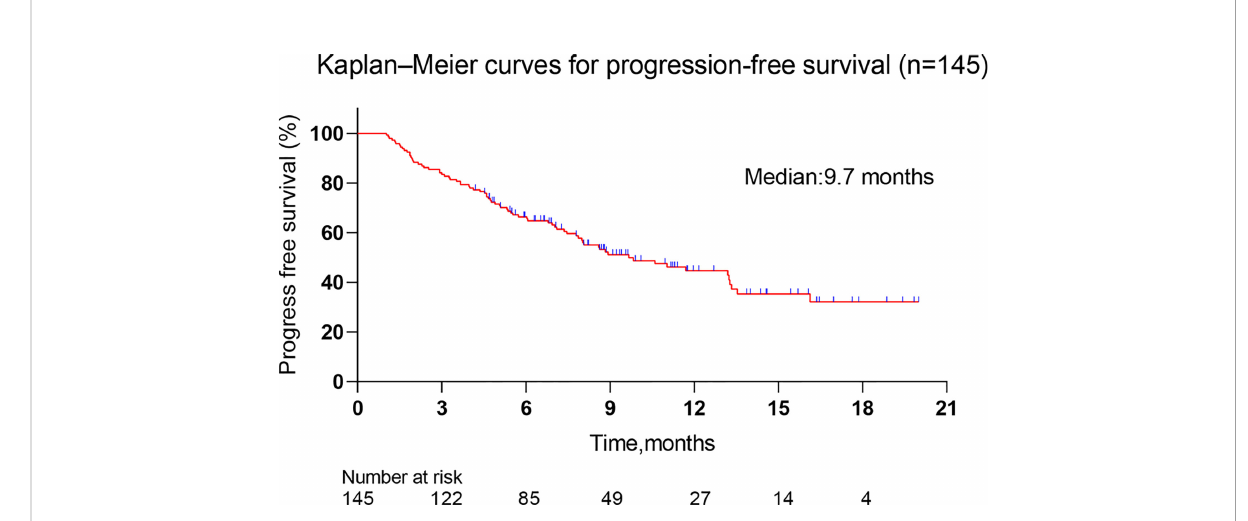
FIGURE 2 Kaplan – Meier curves for progression-free survival. The median follow-up was 12.5 months (4.5-20 months), and the median PFS was 9.7 months (1-16.1 months).